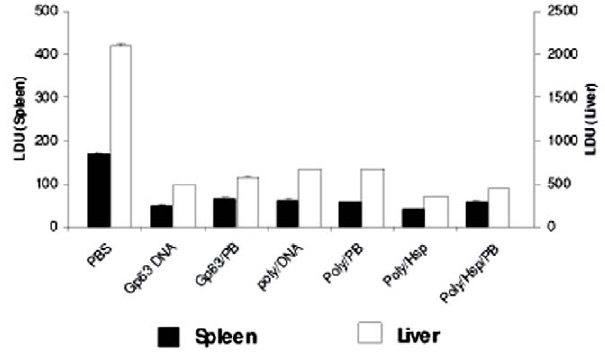
Figure 5. Parasite load in liver and spleen. All the vaccinated and control groups (as described in Fig. 2) were challenged intravenously (i.v.) with 2 6 10 7 Leishmania donovani promastigotes on day35. Four weeks after the challenge, mice were sacrificed and Leishman Donovan units (LDU) were calculated from liver and spleen impression smears. The mean LDU 6 SE is shown (n=6) mice per